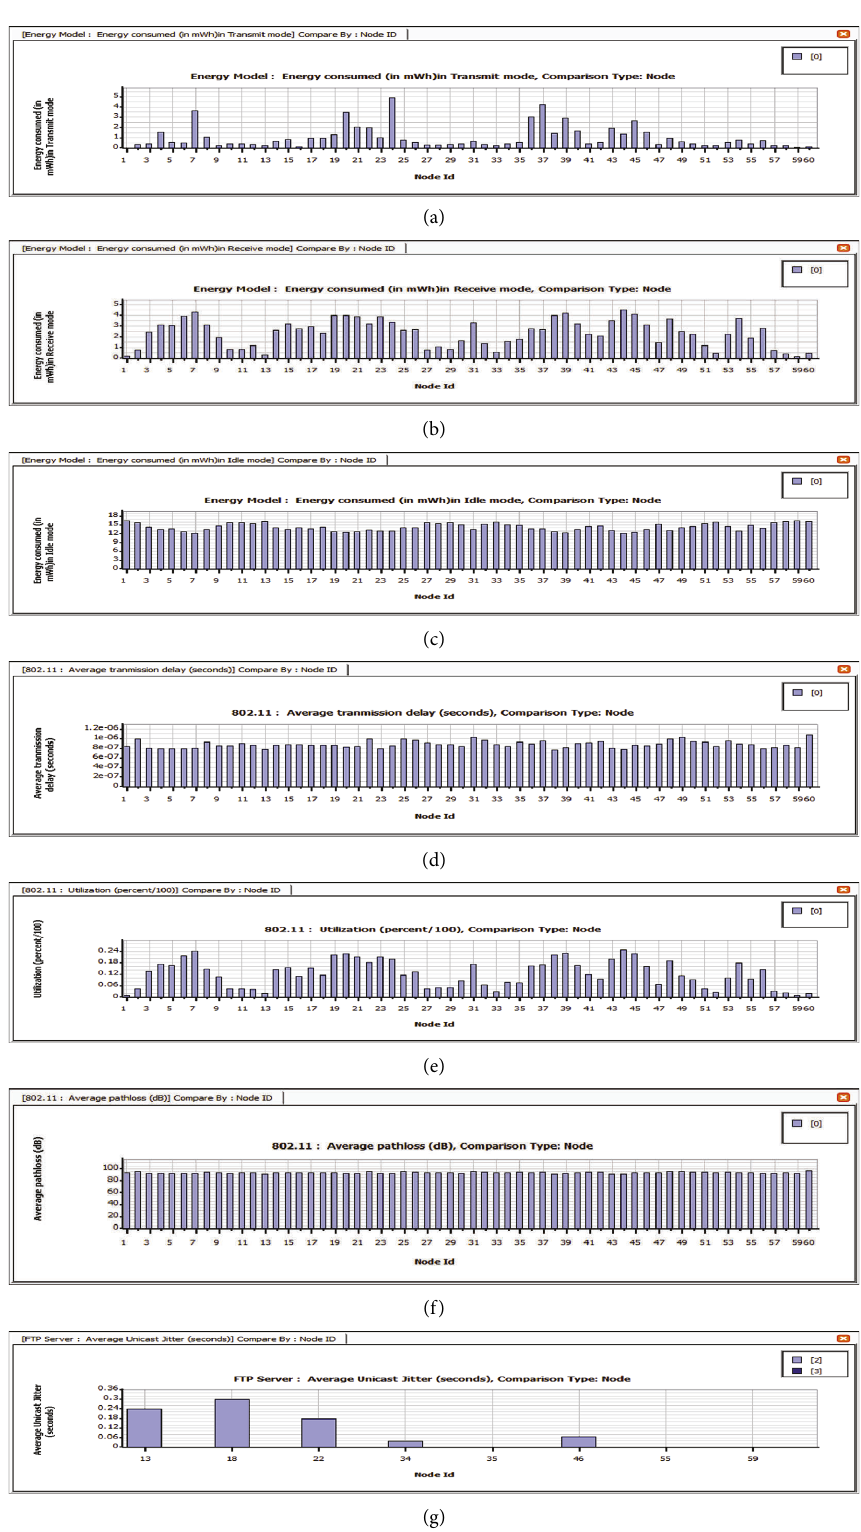
Figure 16: (a) Transmit mode energy consumption of ZRP for FTP deployment. (b) Receive mode energy consumption of ZRP for FTP deployment. (c) Idle mode energy consumption of ZRP for FTP deployment. (d) Average transmission delay of ZRP for FTP deployment. (e) Percentage of utilization of ZRP for FTP deployment. (f) Average pathloss of ZRP for FTP deployment. (g) Average jitter of ZRP for FTP